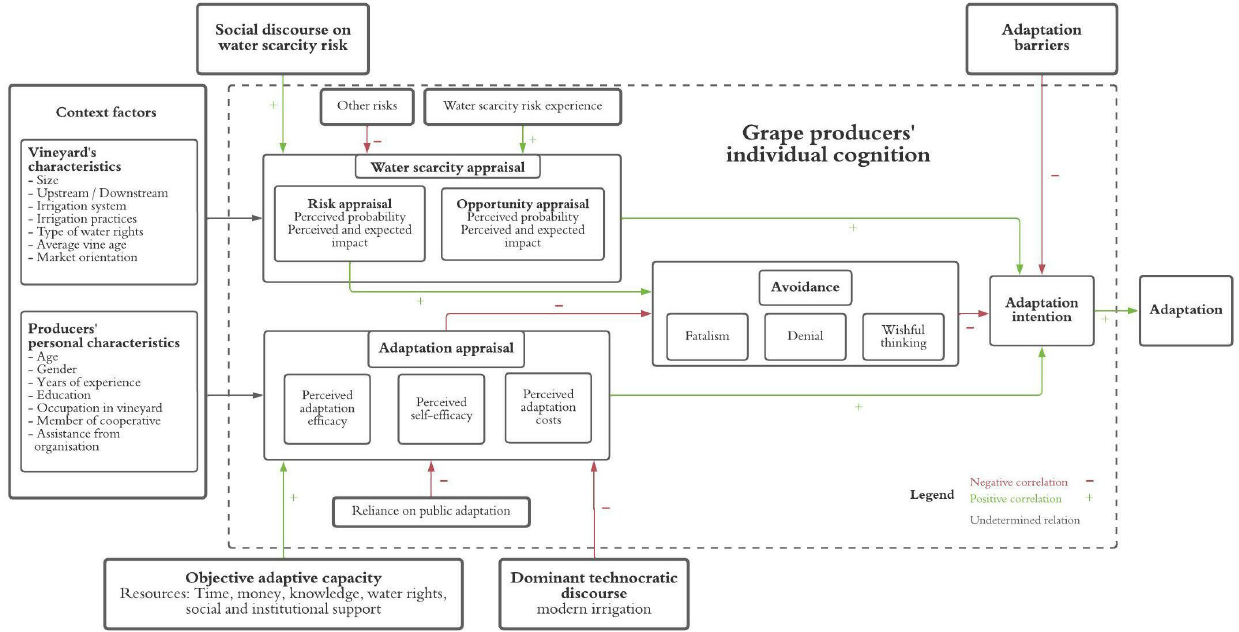
Figure 1. Socio-cognitive model for analysing grape producers’ adaptation to water scarcity (GPAWS) inspired from the MPPACC [17] and FPCCA [18].